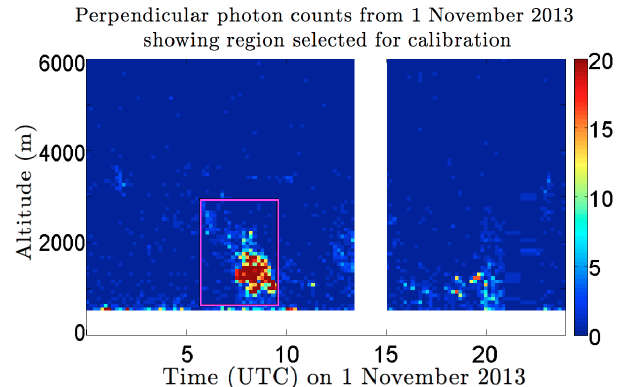
Figure 3. Colour plot of perpendicular channel coadded and corrected photocounts. Magenta box below 3000m between 05:00UTC and 10:00UTC indicates the region of interest to be used in the calibration